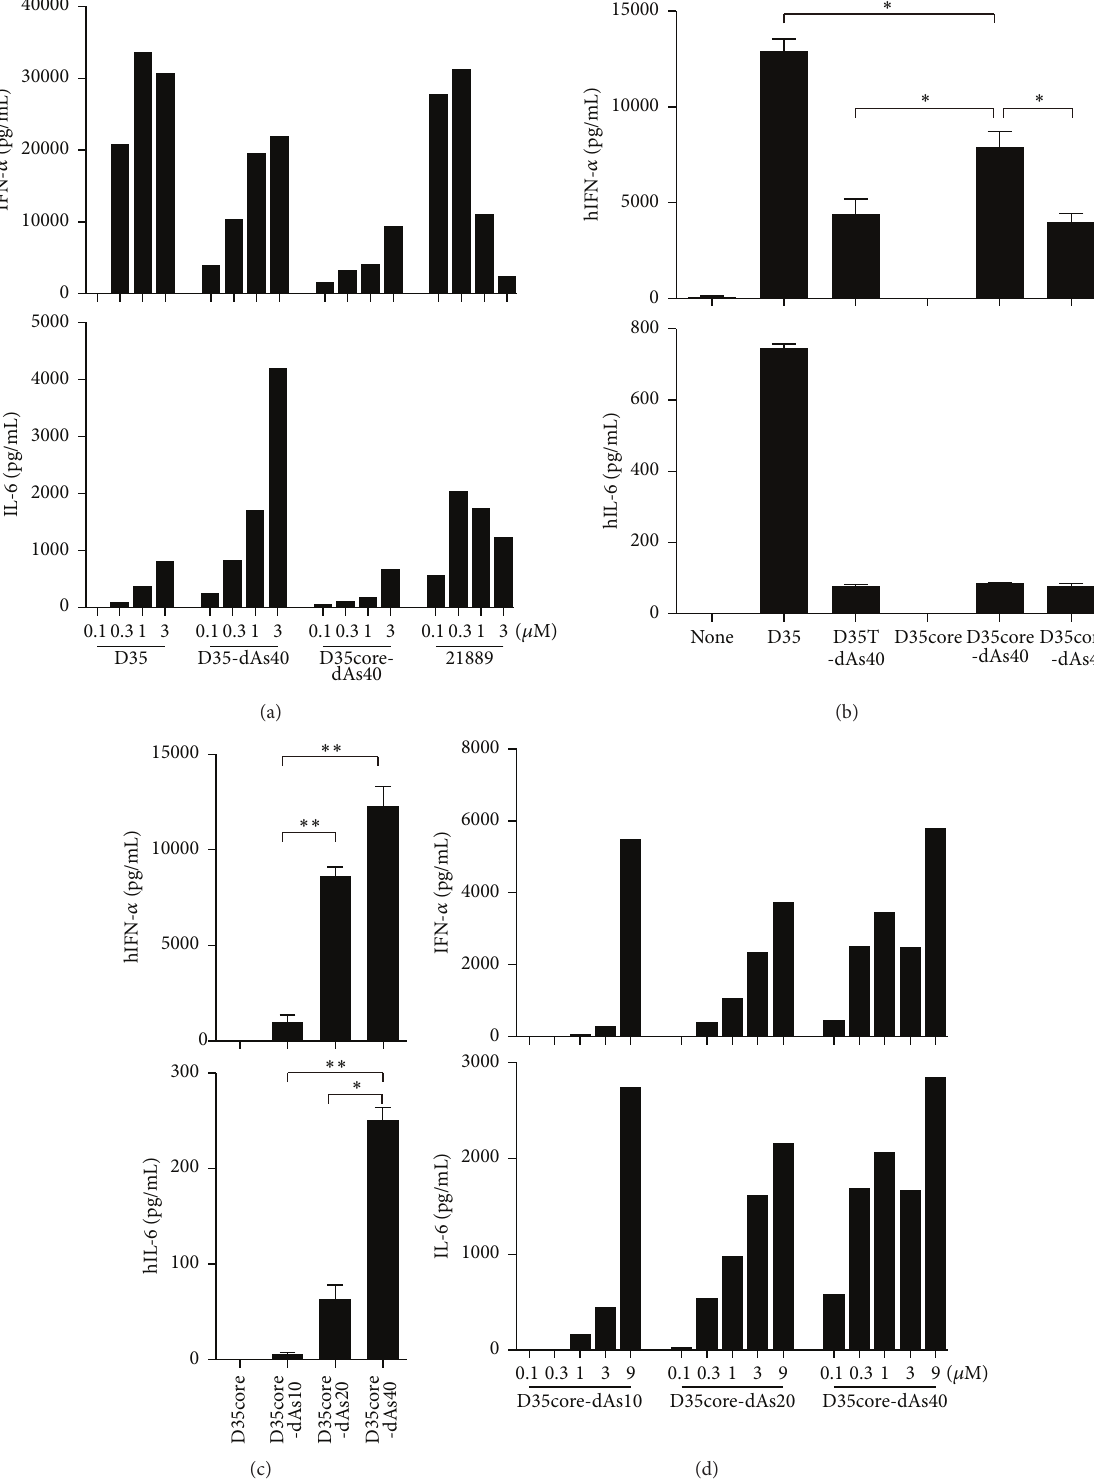
Figure4:BiologicalactivitiesofD35-dAs40andD35core-dAs40.(a)Dose-dependentIFN- 𝛼 productionfromhumanPBMCbytheindicated ODNs. (b) Effect of the adjacent sequence of cytokine inducing activity. D35core plus dAs40 is sufficient to induce IFN- 𝛼 secretion from human PBMC. Bar graph indicates mean ± SEM in triplicate. (c) dAs tail length affects the biological activity of D35core-dAs type ODNs. Human PBMC stimulated with the indicated ODNs (final concentration = 1 𝜇 M), and after 24 h cytokine concentration was determined by ELISA. Bar graph indicates mean ± SEM in triplicate. (d) The tail length and ODN dose relations of the indicated ODNs. The bar graph shows dose-dependent IFN- 𝛼 and IL-6 production from a single well by each stimulation. ∗ 𝑃 < 0.05 ; ∗∗ 𝑃 < 0.01